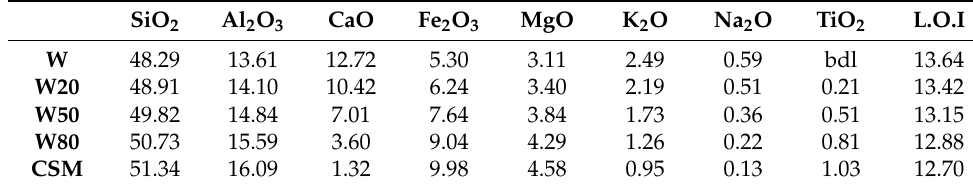
Table 1. Chemical composition (in wt%) of the raw materials W and CSM and their blends W20, W50, and W80 (calculated).